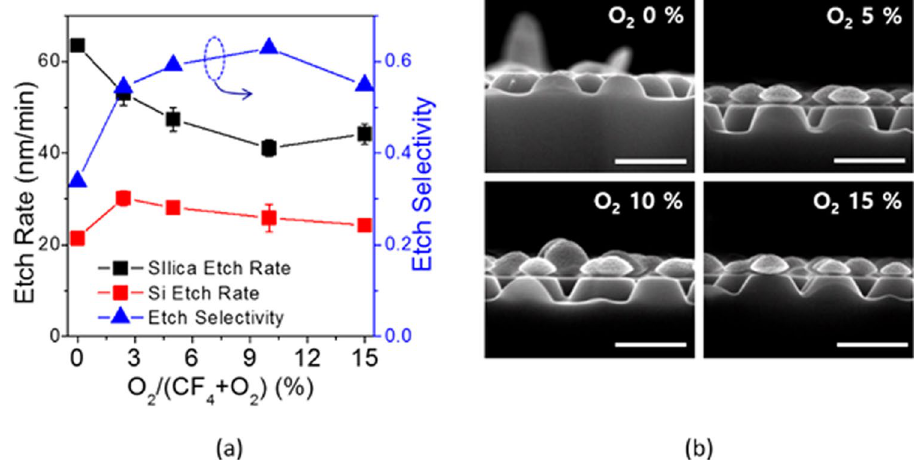
Figure 2. ( a ) Etch rate and etch selectivity of silica beads and Si wafers as a function of oxygen ratio in a CF 4 / O 2 RIE process. ( b ) Cross sectional SEM images of the Si nanostructures fabricated with P520 silica beads as a mask. The oxygen ratio was varied from 0% to 15% to adjust the etch selectivity. The scale bar is 500 nm for all the SEM